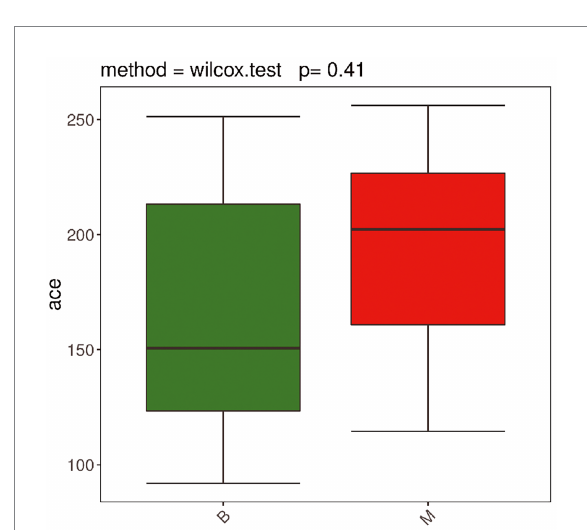
FIGURE 2 Comparison of α -diversity between Group M and Group B. ACE index non-parametric Wilcox test box plot ( p = 0.41). There was no significant difference in α -diversity between the two